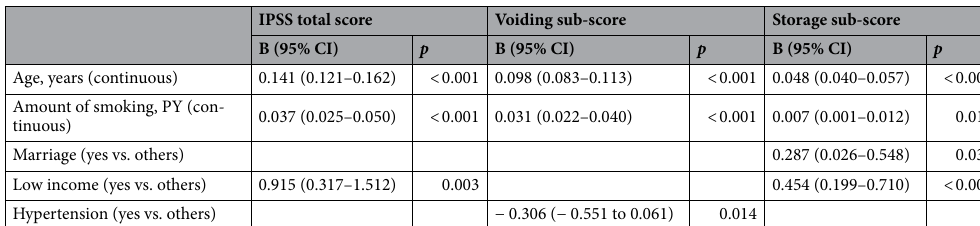
Table 4. Variable associated with I-PSS total, voiding, and storage